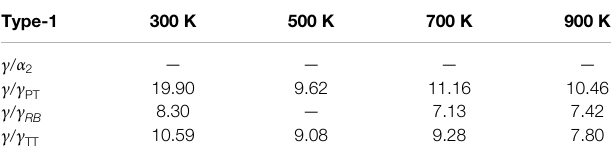
TABLE 5A | Separation energies Γ 0 [J/m 2 ] calculated by Eq. 17 for different temperatures and (a) Type-1 interface model and (b) Type-2 interface